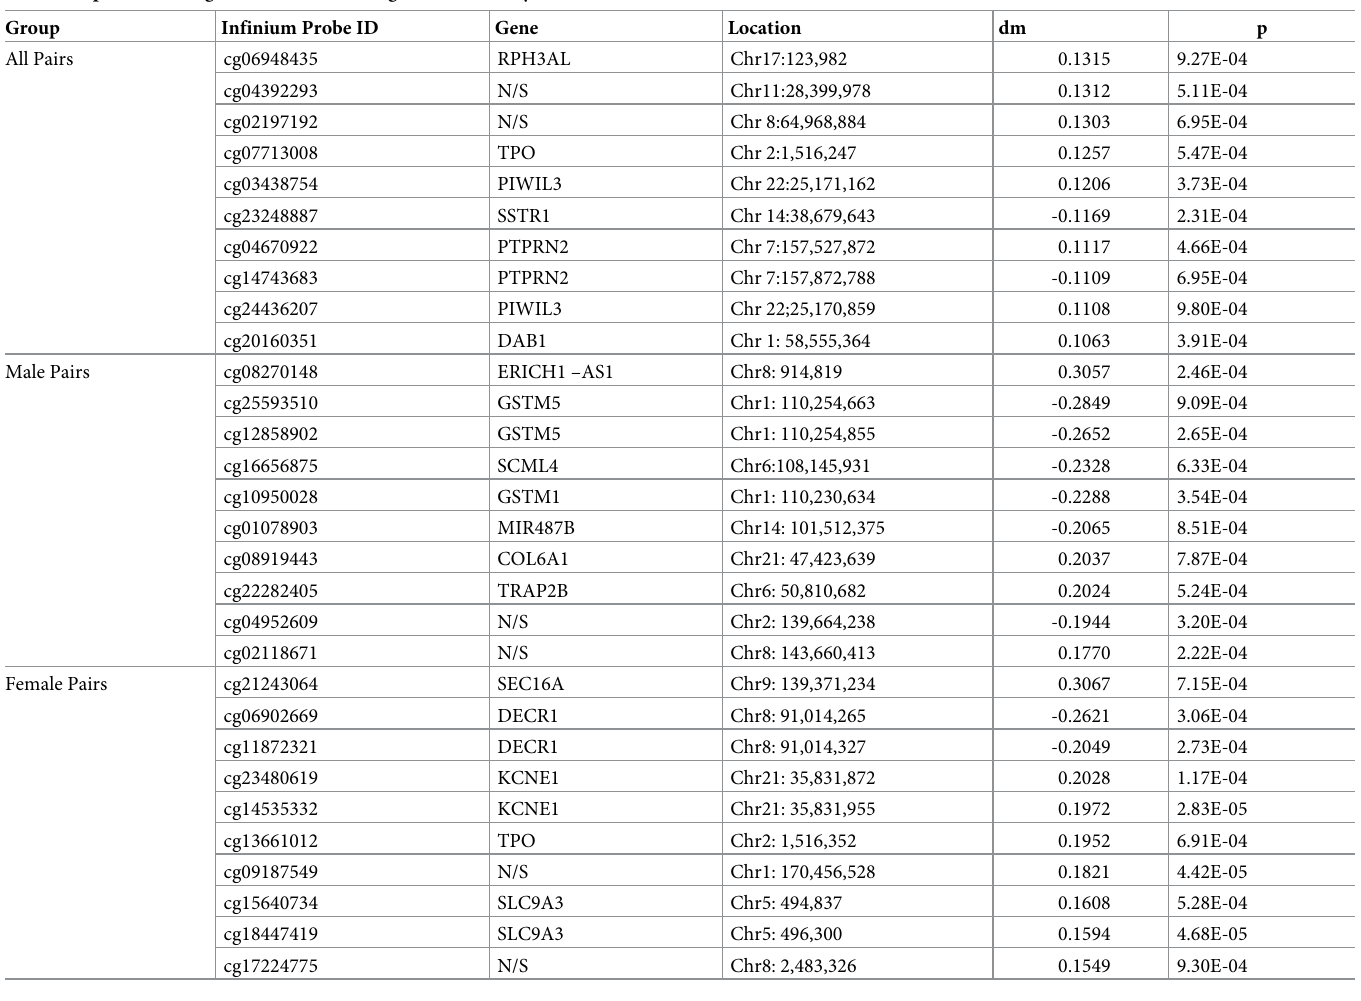
Table 2. CpG sites with greatest absolute change in DNA methylation status (cid:3) . Group Infinium Probe